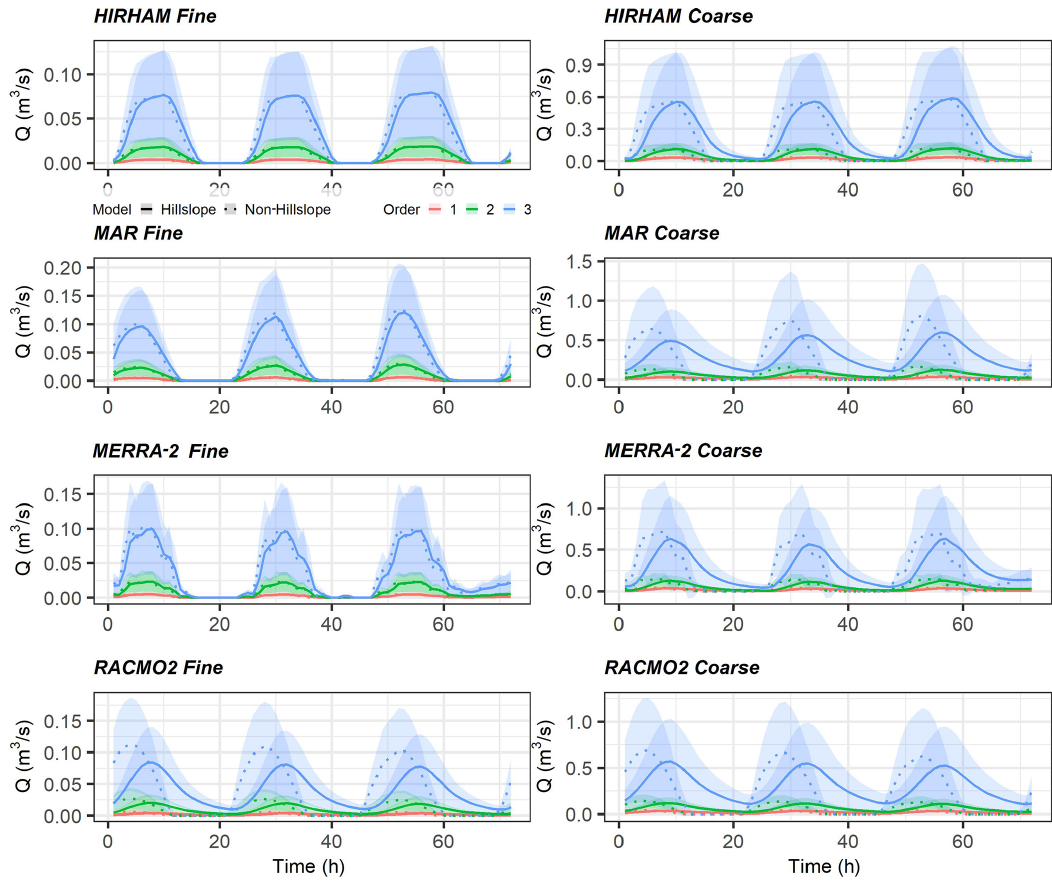
Figure 5. Mean and 1-sigma shaded variability for channel segment hydrographs by order for 1st–3rd order streams for the validation period. Non-hillslope process flows are dashed. Note the increase by a factor of ∼ 10 in flows between fine and coarse networks and the difference in peak timing between hillslope and non-hillslope